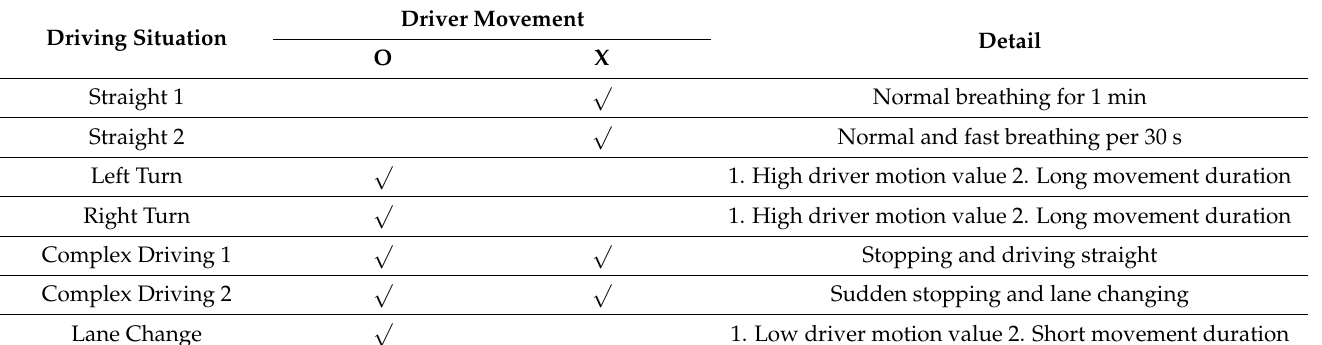
Table 1. Driving experiment conditions according to the